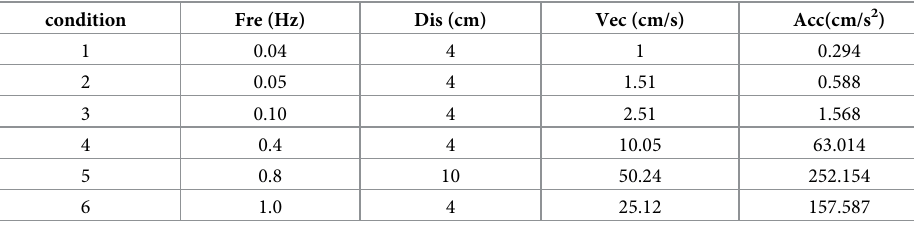
Table 2. Test system feature on sine waves.